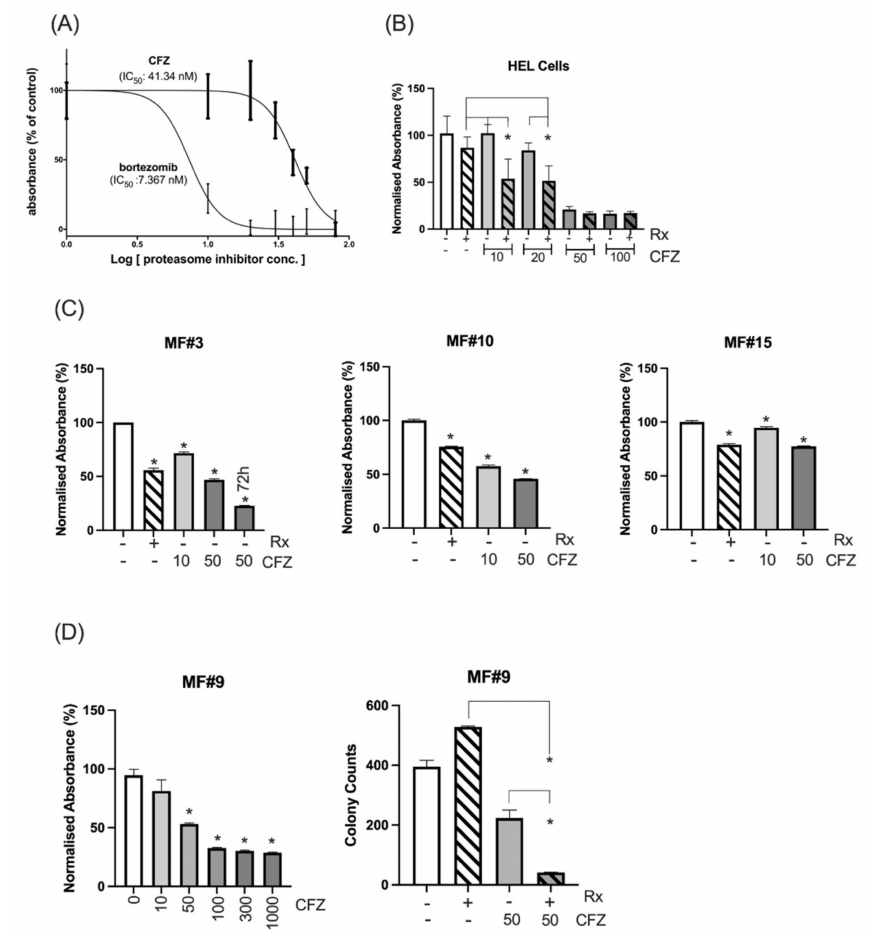
Figure 3. Cell line and primary MF cells’ sensitivity to proteasome inhibitors. ( A ) The IC 50 was measured for CFZ and bortezomib after measuring the proliferation and viability at 72 h using MTS assay. ( B ) Sensitivity of HEL cells to various doses of CFZ alone or in combination with 300 nM ruxolitinib (Rx). Combination of ruxolitinib with CFZ at 10 or 20 nM significantly increased the inhibition of the HEL cells compared to either ruxolitinib ( p value: 0.01 and 0.005 respectively) or CFZ ( p value: 0.001 or 0.01 respectively) after 72 h. * represents p value < 0.05 for the comparison between the combination therapy and either treatment. The inhibition at 50 or 100 nM CFZ alone or in combination compared to control was significant. The Y axis represents the normalized absorbance to untreated control. ( C ) CD34 + cells from 3 MF patients showed sensitivity to 10 and 50 nM CFZ as measured by MTS assay at 24 h (For MF#3 the viability of the cells at 50 nM CFZ was also measured at 72 h). Y axis represents the % of absorbance relative to the untreated control. The columns represent the mean from at least 3 technical replicates (* represents a significant p value in comparison to untreated control). Please see the p values of the comparison between any two conditions in Table S3. ( D ) (Left) Ruxolitinib resistant triple-negative MF#9 showed sensitivity to CFZ, and this sensitivity became significant at 50 nM ( p = 0.0001) with higher doses of CFZ leading to higher suppression as measured by MTS assay at 48 h (results are presented as mean and error bars of at least 3 replicates). The Y axis represents the normalised absorbance of the MTS assay. (Right) Colony formation assay shows CFZ has a significant inhibitory impact on stem/progenitor cells at 50 nM which increased several times in combination with ruxolitinib. The data for each condition was achieved by reading the number of colonies from two dishes (duplicates for each condition) and presented with error bars (*: p value <